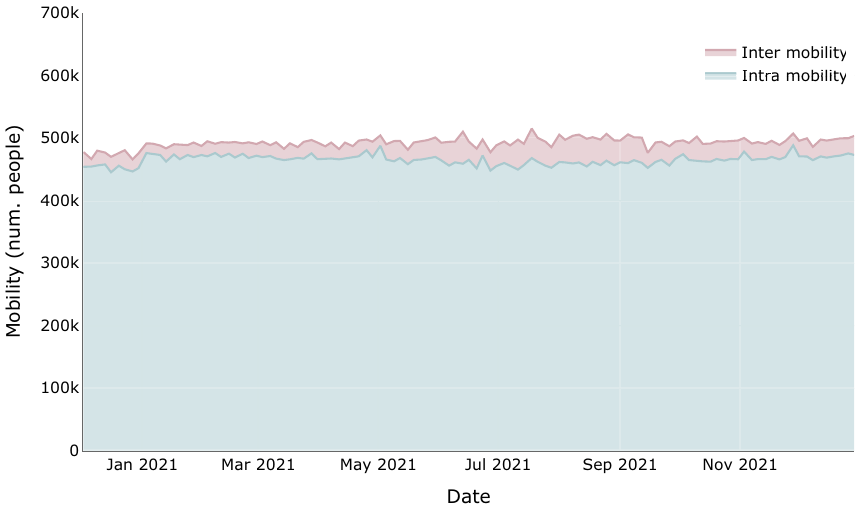
Figure 6. Mobility fluxes in Cantabria, separating the contributions of the two components: intra-mobility (people that move inside Cantabria) and inter-mobility (people that arrive to Cantabria).